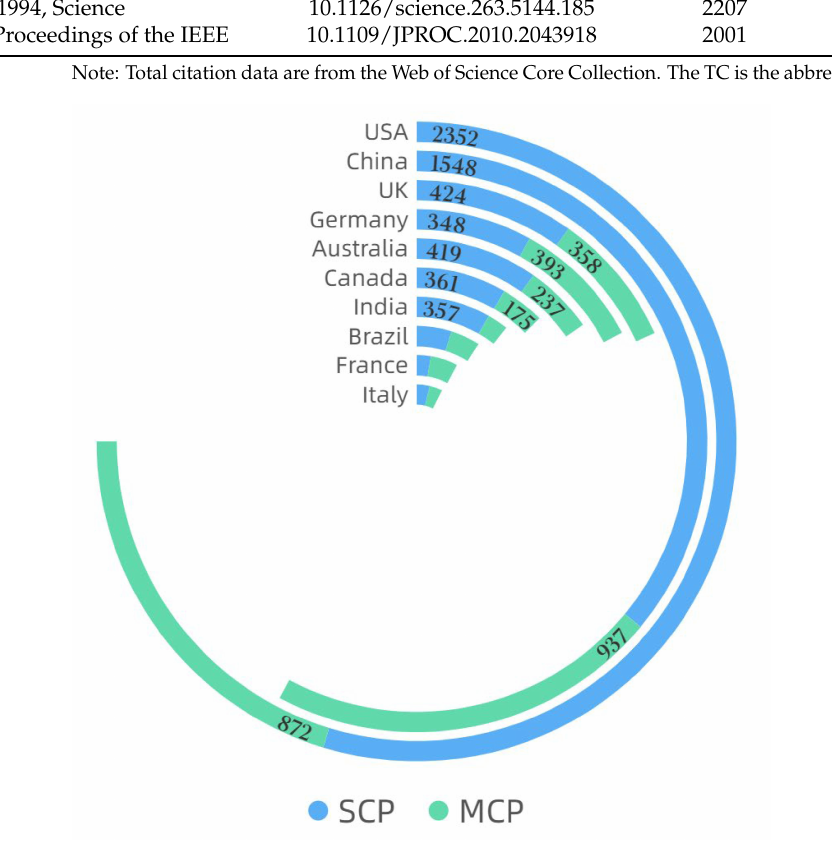
Figure 3. Top 10 Countries in Terms of the Impact of Land Use Change on Soil Carbon Sequestration from 1985 to 2021 and the Number of Publications. MCP is the abbreviation of Multiple Country Publications, indicating that the author of the same paper comes from multiple countries; The SCP is the abbreviation of the Single Country Publications, indicating that the same paper authors are all from the same